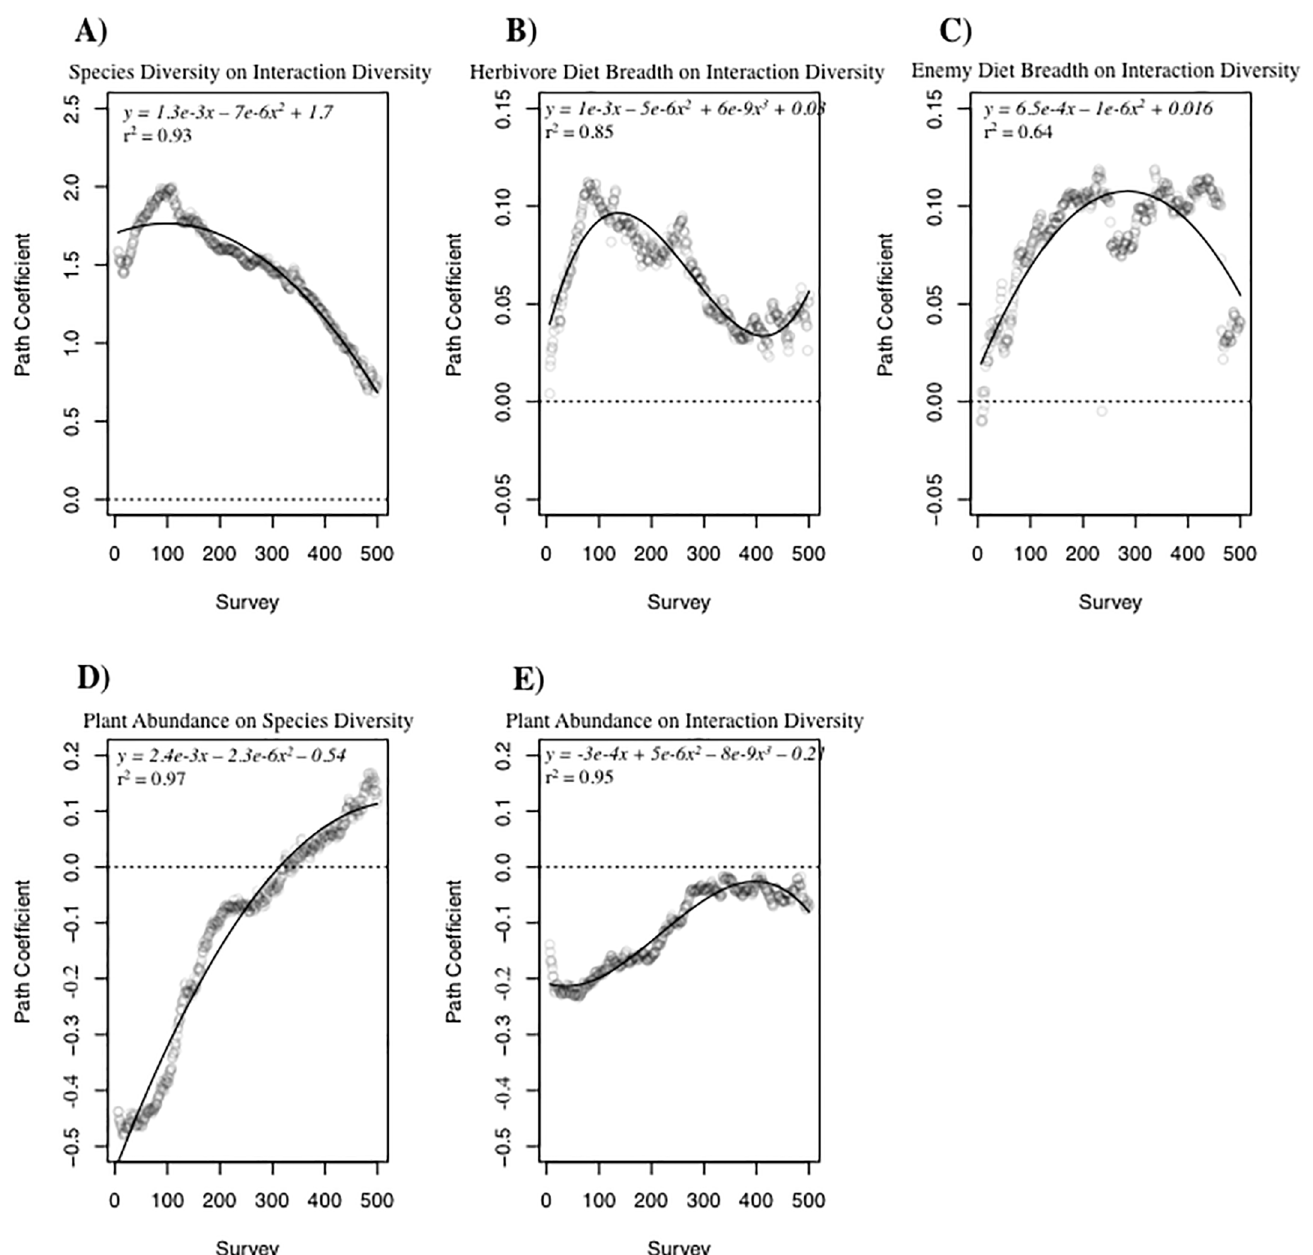
Fig 5. Scatterplots displaying the relationship between the strength of each path coefficient and the number of sampled interactions included in the path analysis (Fig 5), with the exception of paths associated with connectance. The strength of the path coefficient is shown on the y-axis and number of observed interactions included in the model is shown on the x-axis. The solid line represents outcome of linear or polynomial regressions. Path coefficients used in these analyses were significant (P <